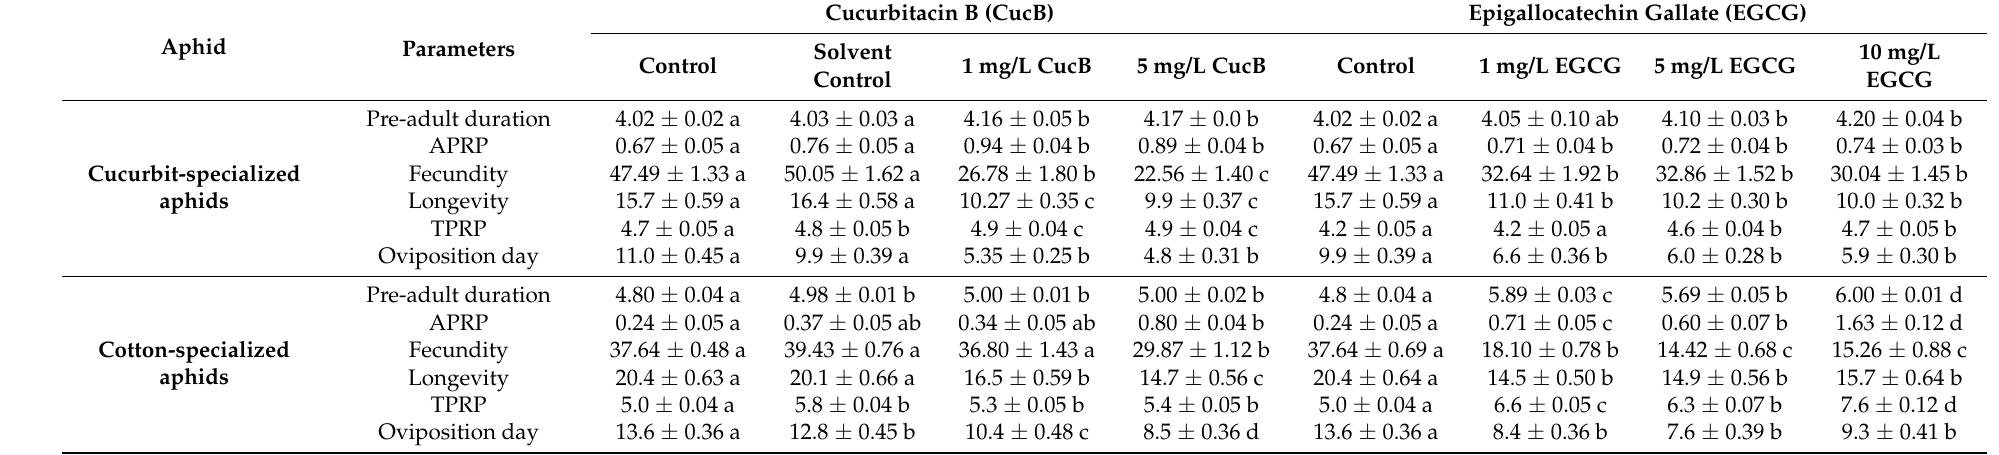
Table 1. Effect of CucB and EGCG on fecundity, longevity, adult pre-reproductive period (APRP), total pre-reproductive period (TPRP), and mean and oviposition day of Aphis gossypii.